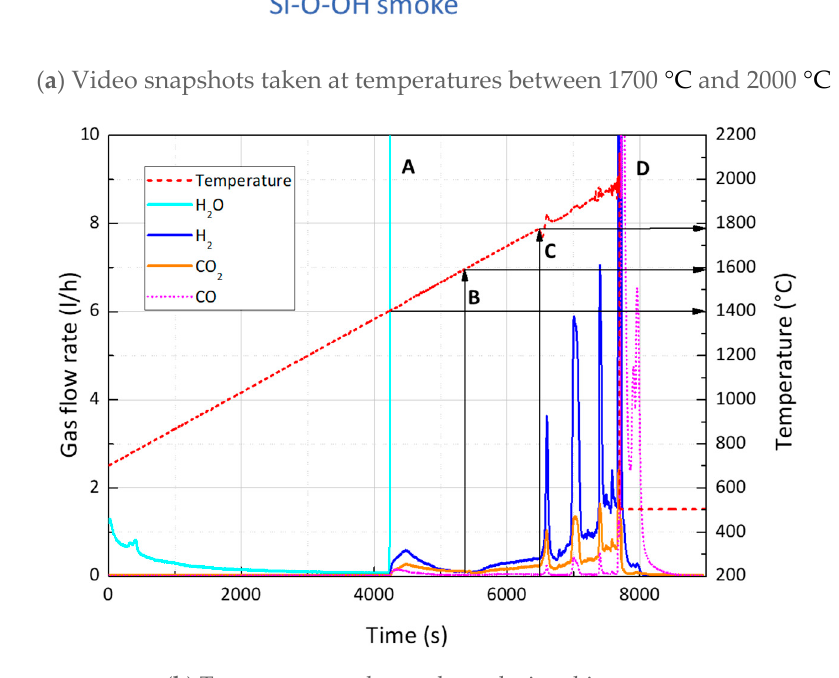
Figure 12. Results of a steam oxidation ramp test with a SiC cladding tube segment at temperatures between 1400 °C and 2000 °C [46].